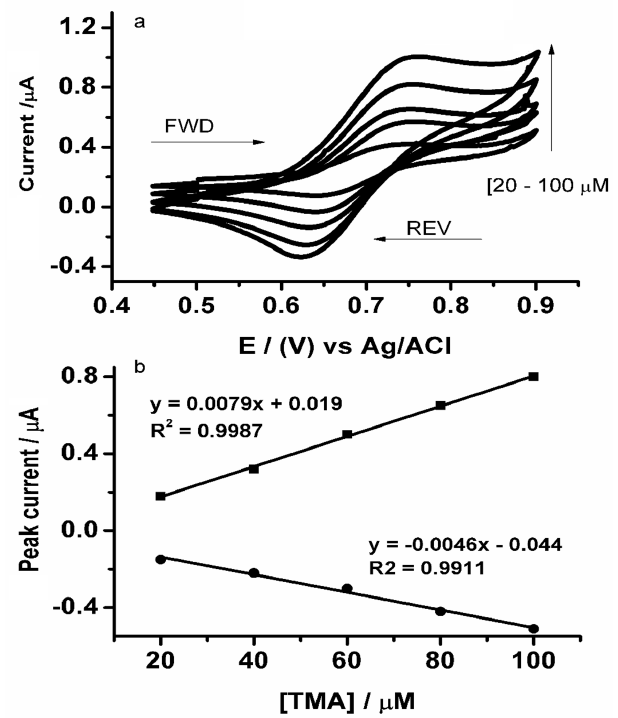
Figure 3. Voltammograms of TMA + transfer at various concentrations 20, 40, 60, 80, and 100 µM (as an arrow indicated) at scan rate 10 mV/s ( a ). The calibration curve of the limiting and peak current for the forward (positive) and reverse (negative) scans, respectively, versus TMA + concentrations ( b ).